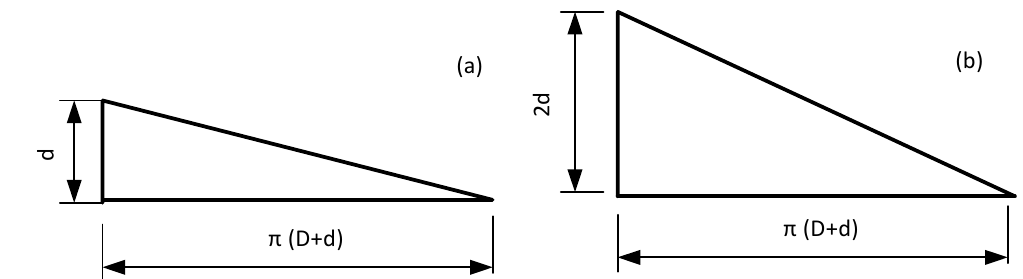
Figure 3. Different cylinder expansion length of wire harness: ( a ) single wire coil deployment structure, ( b ) parallel coil deployment structure.